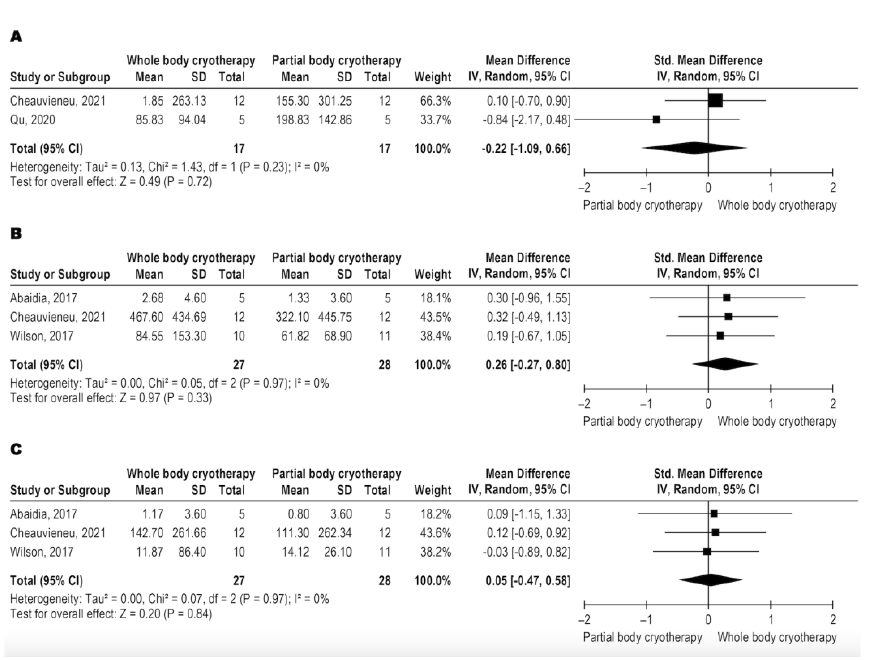
Figure 5. Metanalysis comparison between WBC and PBC for CK ( A ) immediately-post intervention [12,20], ( B ) 24 h after intervention [13,20,25], and ( C ) 48 h after intervention